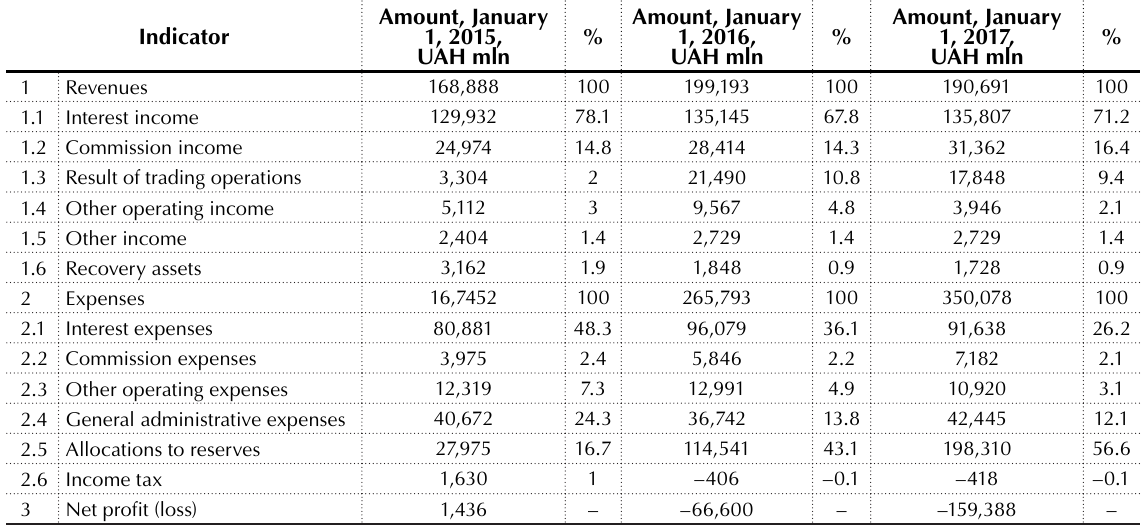
Table 5. The structure of incomes and expenditures of Ukrainian